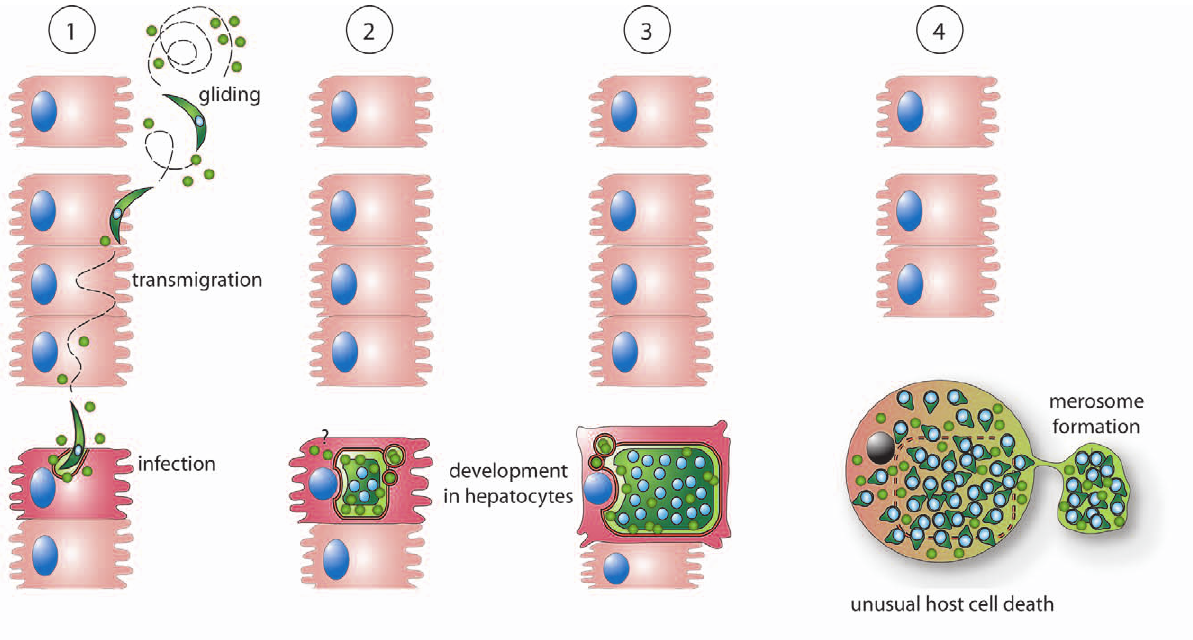
Figure 9. Possible roles of PbICP during the exoerythrocytic development of P.bergheiinvitro . 1: PbICP (green circles) is secreted by free gliding sporozoites and supports invasion of HepG2 cells. Intracellular sporozoites and trophozoites continue to express and partially secrete PbICP. Thus PbICP can potentially control parasite-derived cysteine proteases as well as host cell cysteine proteases. 2 + 3: During schizogony, PbICP is predominately located in the PV and the parasite cytosol, suggesting that during this developmental phase, parasite cysteine proteases are the main target of the inhibitor. However, it cannot be excluded that small portions of the inhibitor, which are beyond the detection level for IFA, are still exported into the host cell cytoplasm. 4: At the end of the liver stage, upon disruption of the PVM, a substantial amount of PbICP is passively released into the host cell cytoplasm. At this stage, the main function of PbICP might be inhibition of host cell cysteine proteases to allow a slow and ordered host cell death and merosome